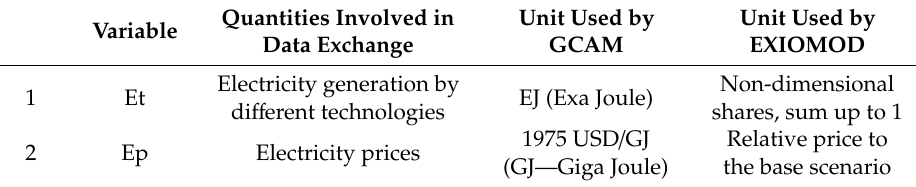
Table 2. Comparison of units for data mediation between GCAM and EXIOMOD.